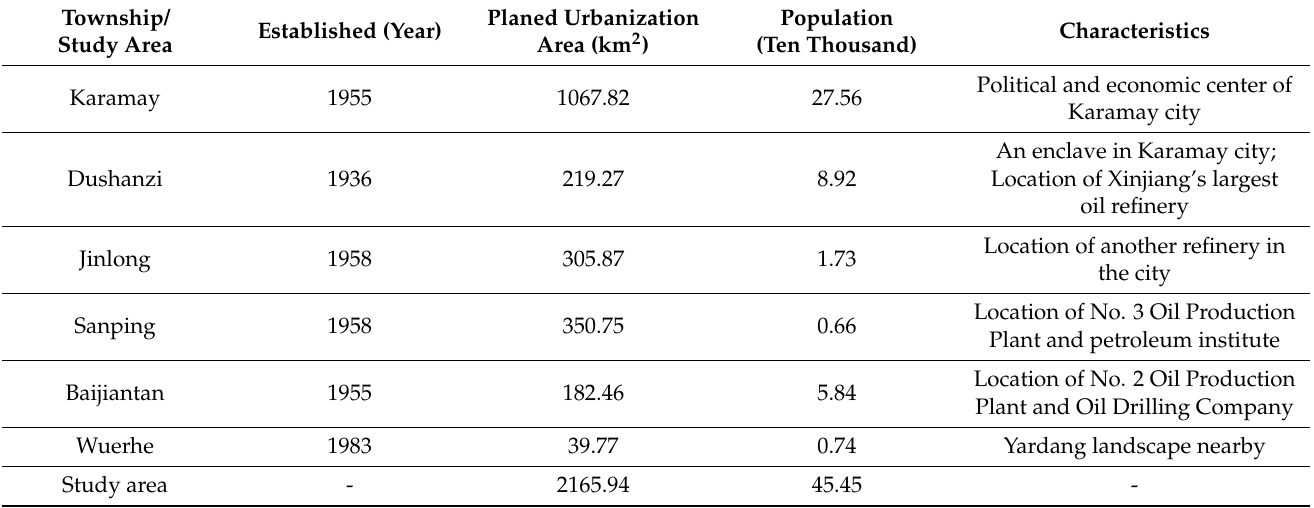
Table 1. Basic information about study